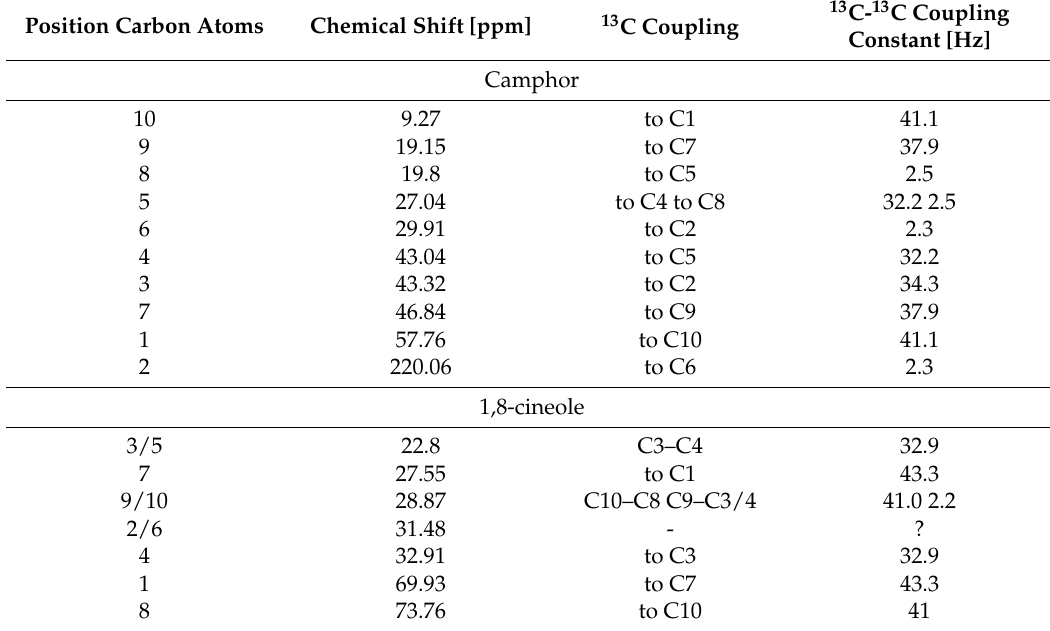
Table 4. NMR analysis of camphor and 1,8-cineole derived from chloroform-d extraction of spike lavender leaves pulse-labelled with 13 CO 2 for 5.2 h; chase time 192